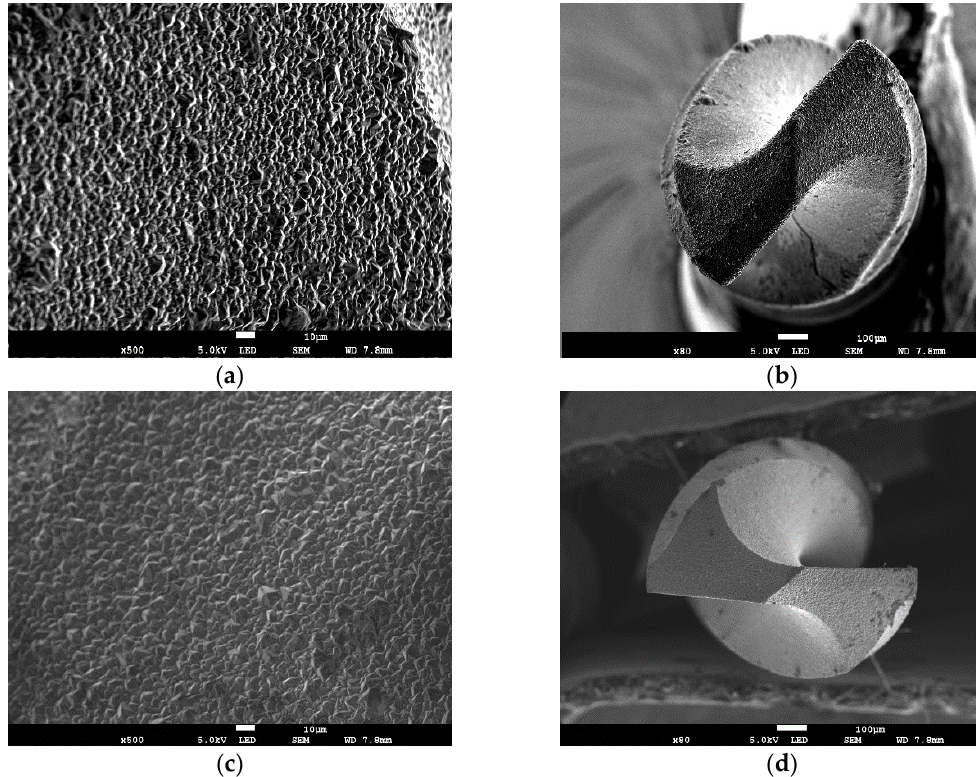
Figure 1. Scanning electron microscopy (SEM) images of surface morphology and whole shape of the ( a , b ) microcrystalline diamond (MCD) and ( c , d ) roughening pretreatment microcrystalline diamond (RMCD) coated drill bits, respectively.